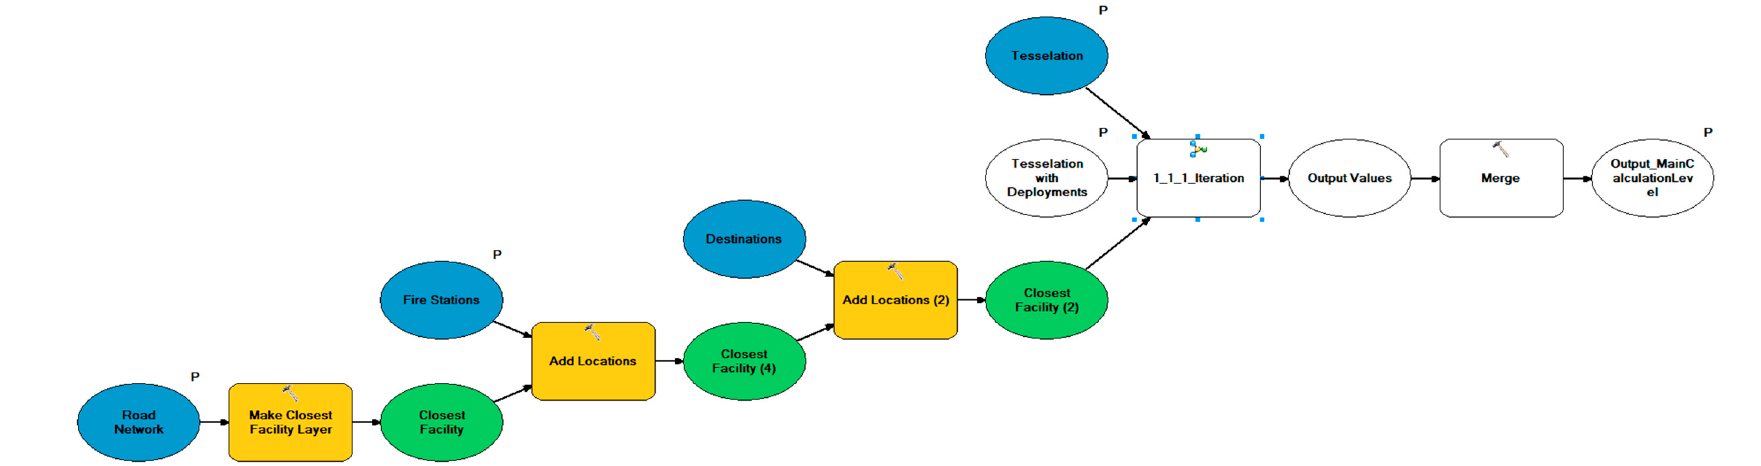
Figure A2. Main Calculation Level (CF_Hauptteil) in ArcMap ModelBuilder.